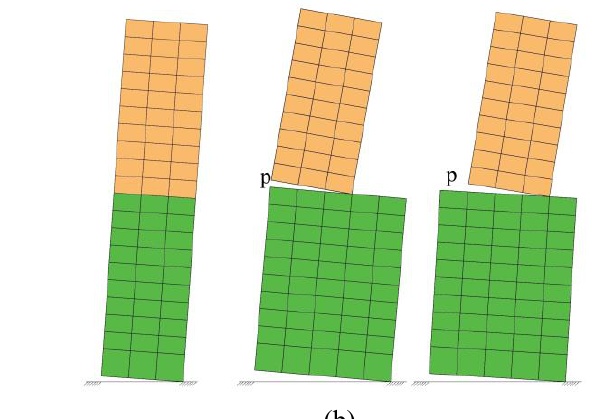
Fig. 7. Probable displacement pattern of